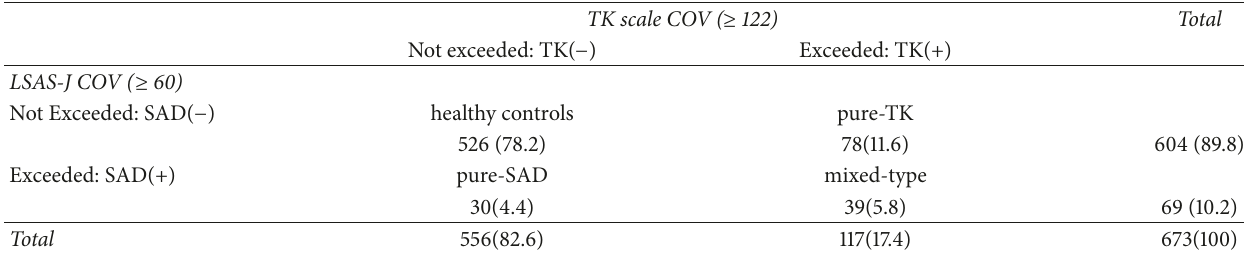
Table 3: Cut-off values and number of subjects in each